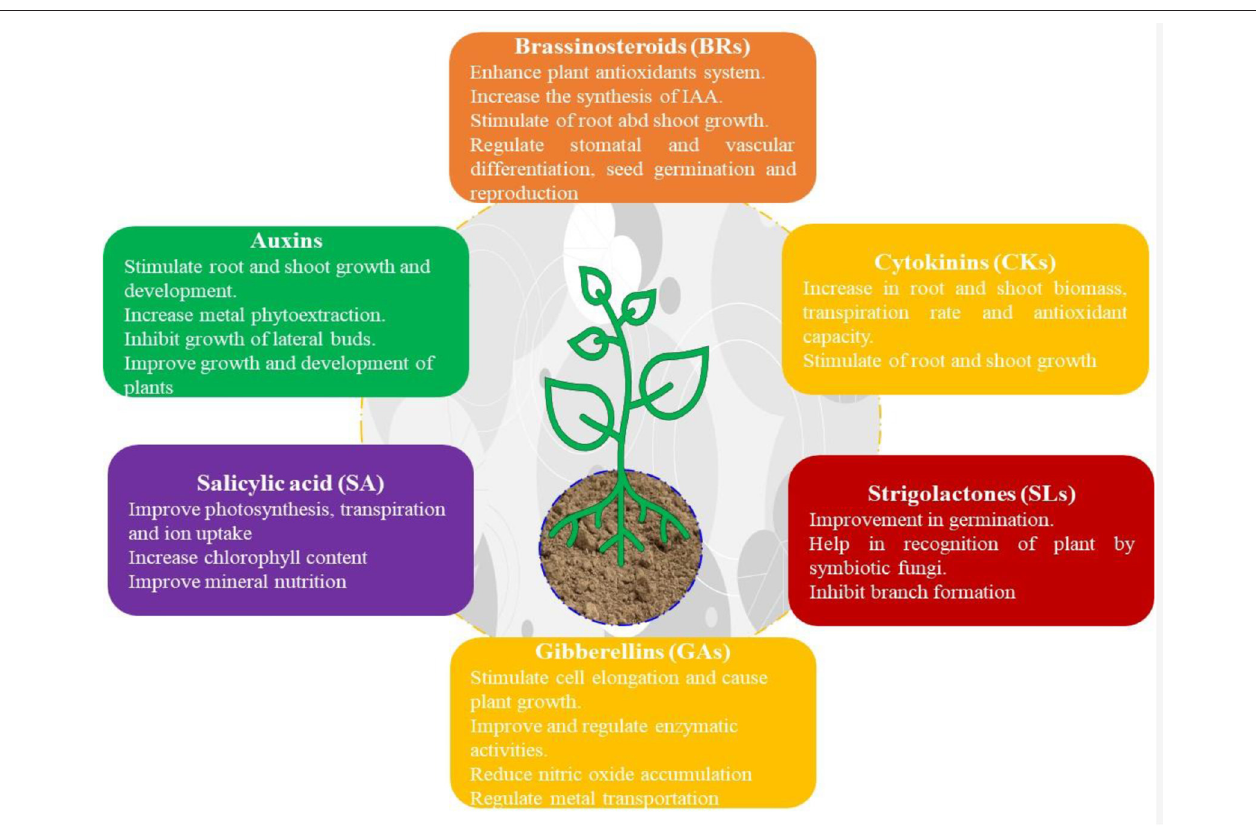
FIGURE 3 | Role of selected PGRs on plant growth and